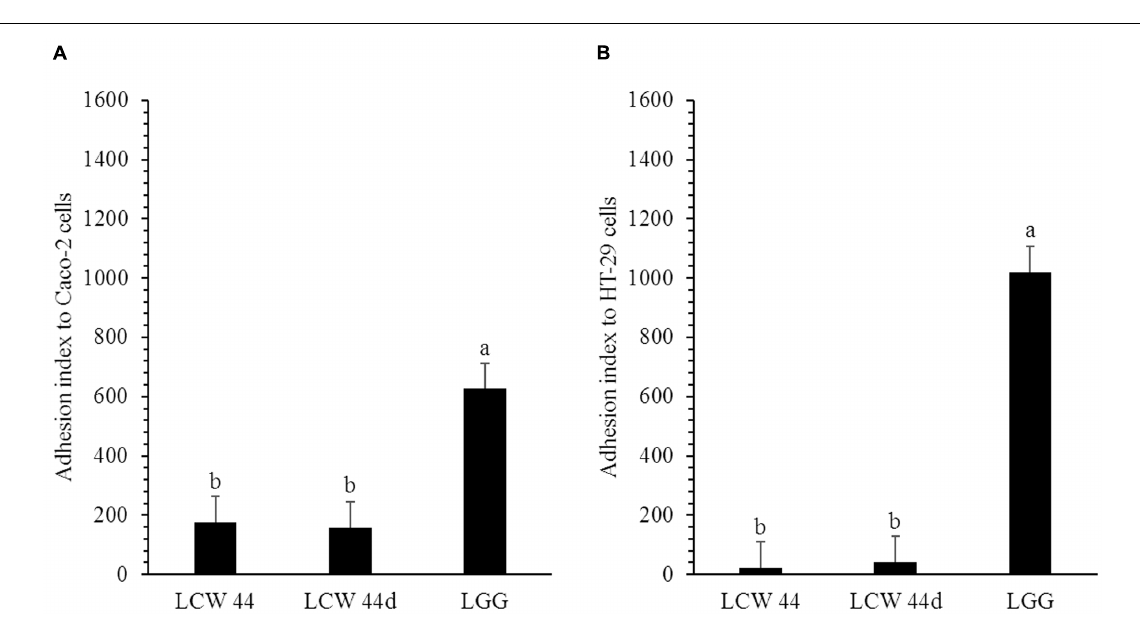
FIGURE 4 | Adhesion of E. faecium LCW 44, LCW 44d and L. rhamnosus GG to Caco-2 cells (A) and HT-29 cells (B) . Adherent bacteria titer was measured by plating on agar after 1 h of contact. Error bars indicate the standard error of the mean. Different letters indicate significant difference between assays (Tukey’s HSD test, P < 0.05, n =